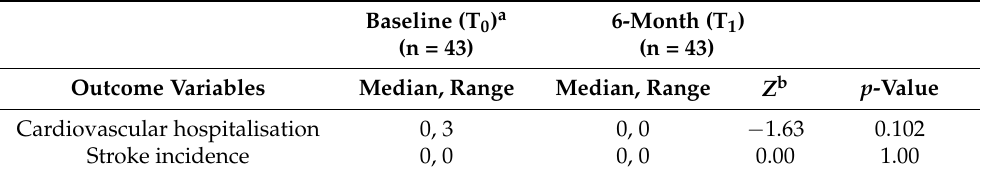
Table 5. Clinical outcomes at baseline and 6-month